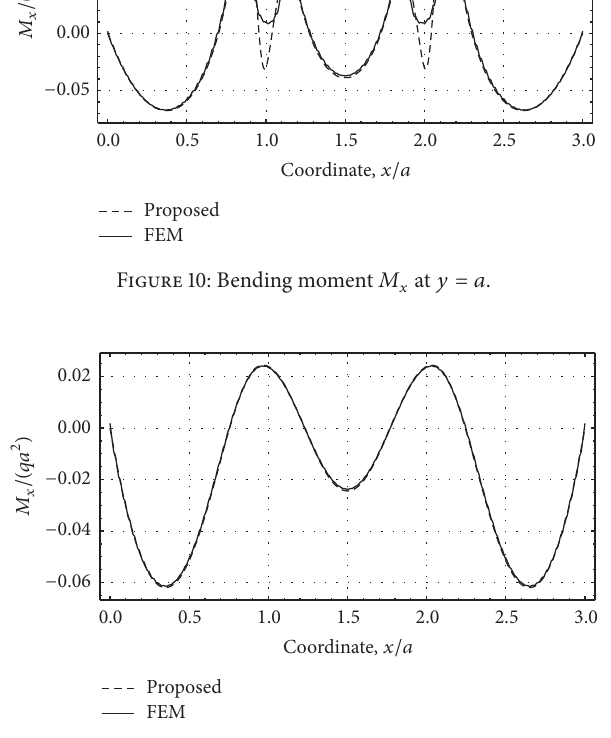
deviate from the FEM solution for most of the points with a maximum difference of